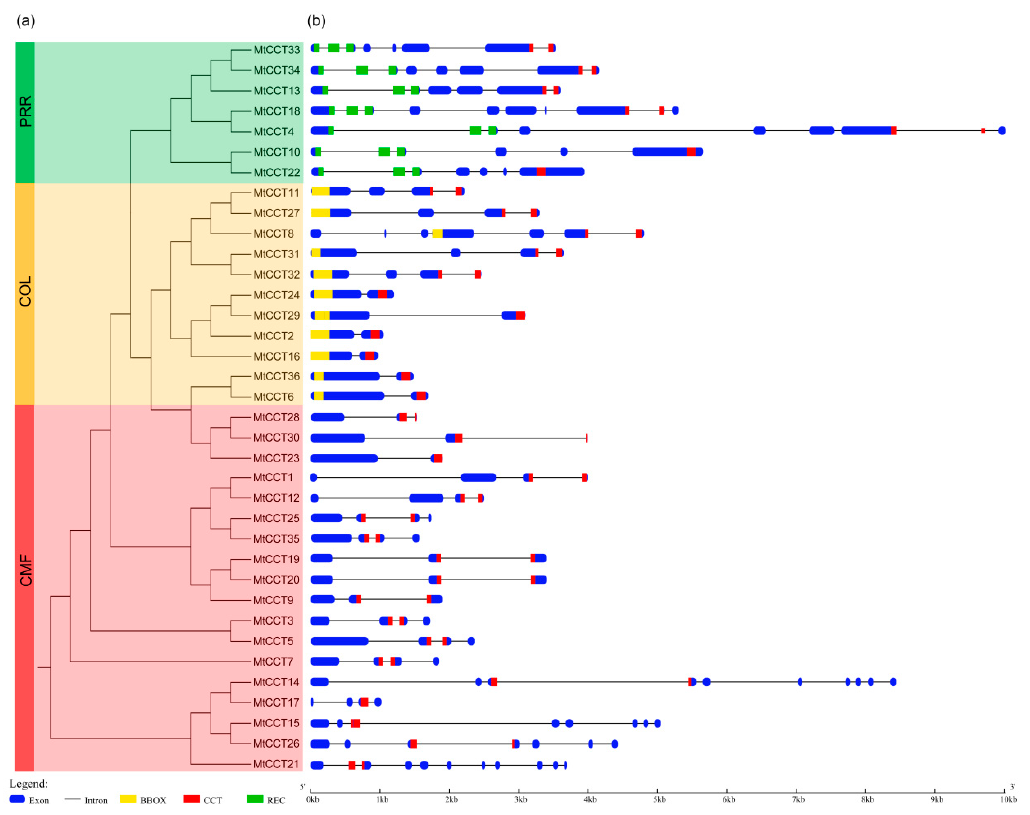
Figure 1. Phylogenetic relationship, gene structure and architecture of conserved domains of MtCCT genes. ( a ) Phylogenetic tree of MtCCT genes (36 in total) was constructed based on the full-length sequences of proteins using MegAlign. Di ff erent subfamilies are highlighted in di ff erent colors: PRR in green, COL in yellow, and CMF in red. ( b ) Exon-intron structure and conserved domains of MtCCT genes. Blue boxes indicate exons; black lines indicate introns; red, yellow and green boxes indicate CCT (CO, COL and TOC1), BBOX (B-box-type zinc finger) and REC (cheY-homologous receiver) domains, respectively.